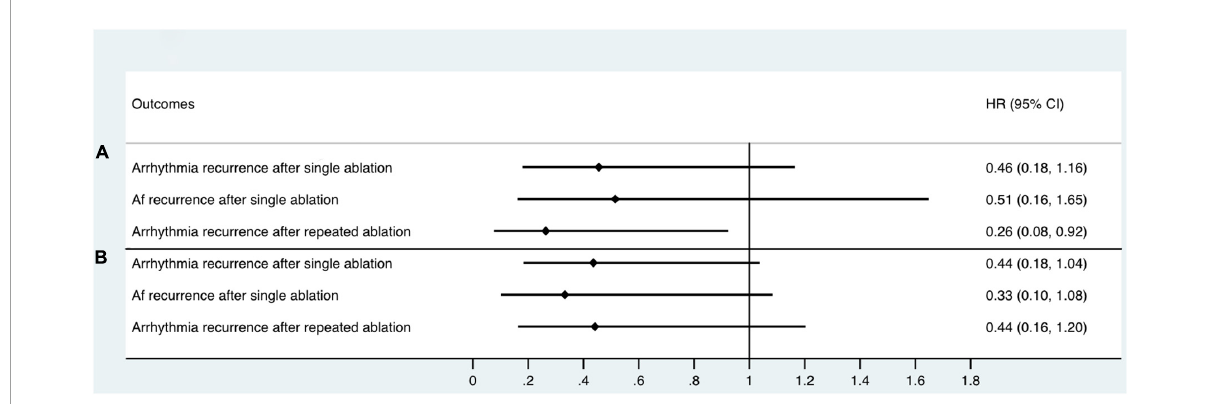
FIGURE5 Cox proportional hazards regression model assessing the association between RA < LA mMSE gradient, intraprocedural termination, and follow-up outcomes. All models were adjusted for age, gender, AF duration, and LA volume. (A) RA < LA mMSE gradient reduced the risk of arrhythmia recurrence after single ablation by 54.4% ( P = 0.101). Similarly, the risk of AF recurrence after single ablation was decreased to 51.5% in RA < LA mMSE gradient group than that in RA > LA mMSE gradient group ( P = 0.264). Finally, RA < LA mMSE gradient group had a significant 73.6% risk reduction for arrhythmia recurrence after repeated ablation than RA > LA mMSE gradient group ( P = 0.037). (B) Intraprocedural termination also showed associations with reduced risk of arrhythmia recurrence after single ablation, AF recurrence after single ablation, and arrhythmia recurrence after repeated ablation. However, the associations between intraprocedural termination and follow-up outcomes did not achieve statistical